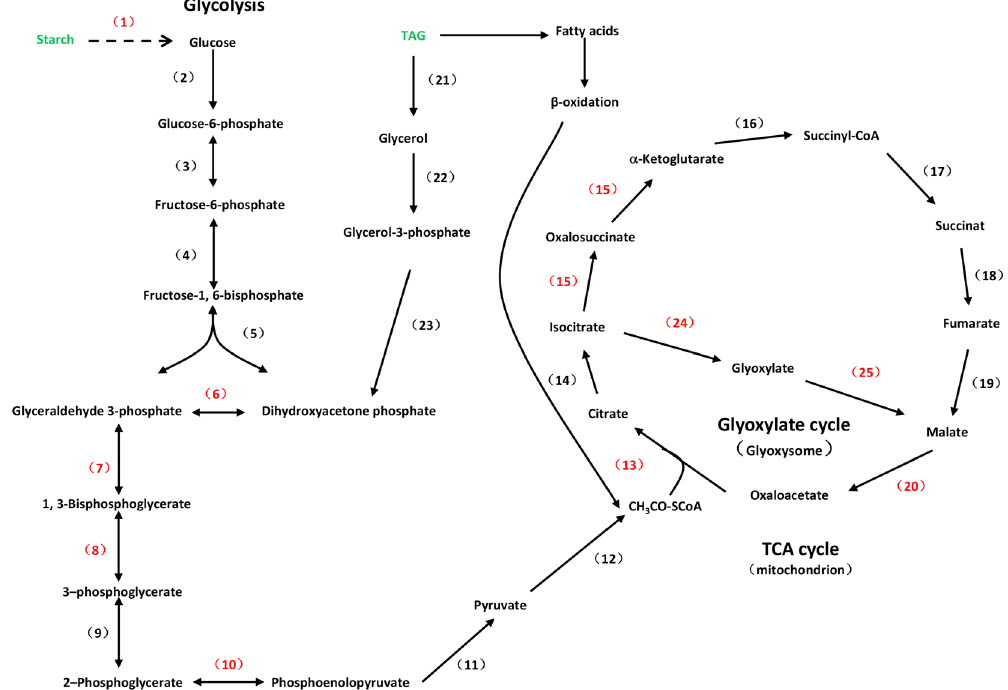
Figure 8. Schematic representation of energy metabolism that melatonin alleviated the inhibitory effects of NaCl stress on seed germination. Glycolysis, TCA cycle and glyoxylate cycle were regulated by melatonin. The arrows represent the direction of the chemical reaction. The Arabic numerals or molecules in red and green are up and down regulated by melatonin, respectively. (1) α , β -amylase (2) hexokinase (3) phosphoglucose isomerase (4) phosphofructokinase (5) aldolase (6) triosephosphate isomerase (7) glyceraldehyde 3-phosphate dehydrogenase (8) phosphoglycerate kinase (9) phosphoglycerate mutase (10) enolase (11) pyruvate kinase (12) pyruvate dehydrogenase (13) citrate synthase (14) aconitase (15) isocitrate dehydrogenase (16) ketoglutarate dehydrogenase (17) succinyl-coa synthetase (18) succinate dehydrogenase (19) fumarase (20) malate dehydrogenase (21) tag lipases (22) glycerol kinase (23) glycerol phosphate dehydrogenase (24) isocitrate lyase (25) malate